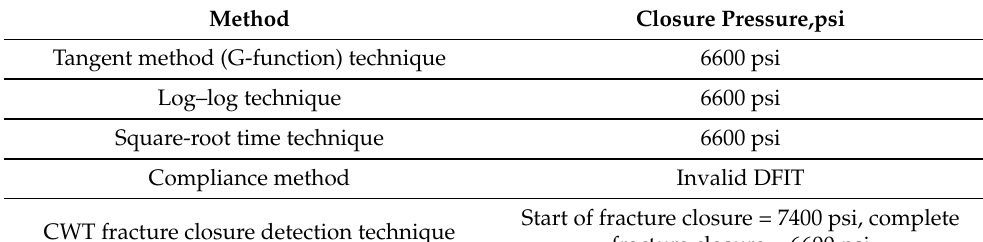
Figure 25. Pumping schedule for well X02. Table 3. Fracture closure pressure for well